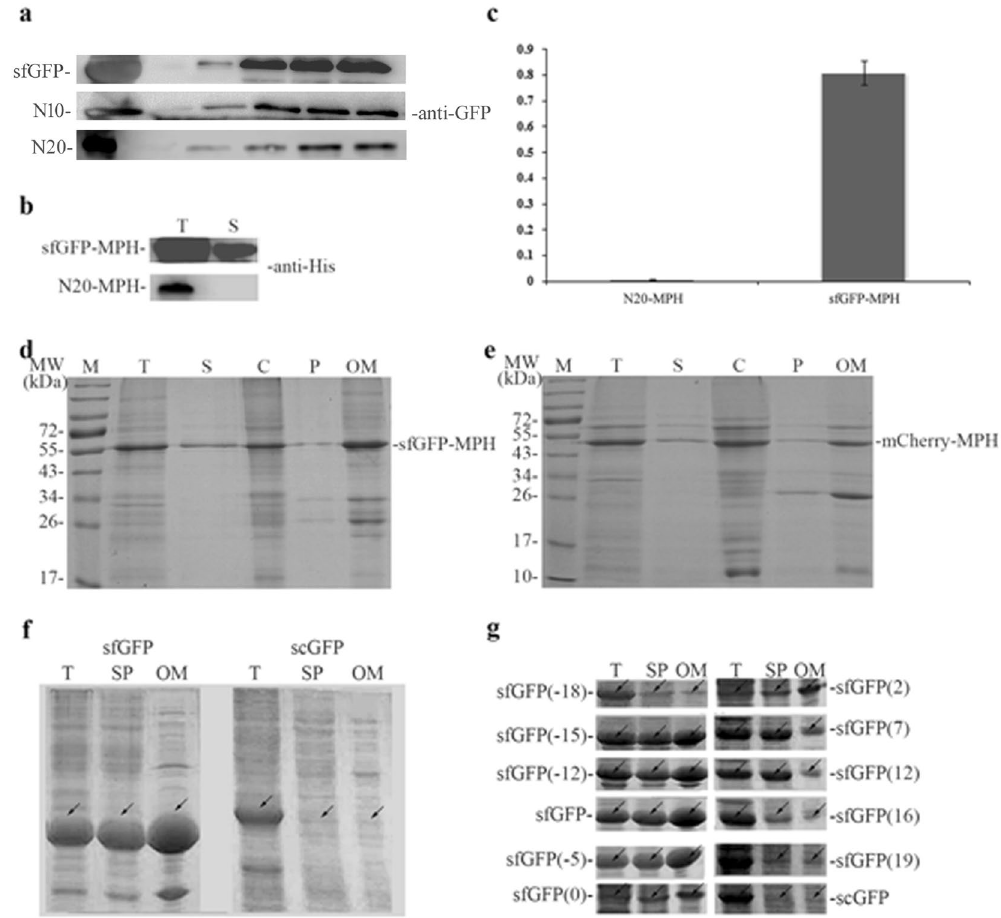
Figure 3. Analysis the auto secetion mechanism of sfGFP in E . coli . ( a ) Western blot annalysis of the extracellular expression of sfGFPs in E . coli ; N10: mutant of sfGFP with deletion of 10 amino acids at its N-terminus; N20: mutant of sfGFP with deletion of 20 amino acids at its N-terminus; anti-GFP: GFP monoclonal antibody; all samples were tested by using GFP monoclonal antibody; ( b ) Western blot annalysis of the extracellualr secretion of sfGFP-MPH and N20-MPH in E . coli ; all samples were tested by using 6 × His mono-antibody; ( c ) Enzyme activity assay of extracellular secretion fusion protein sfGFP-MPH and N20-MPH; N20-MPH: N-terminus 20 amino acids of sfGFP fused to the N-terminal of MPH; sfGFP-MPH: sfGFP fused to the N-terminal of MPH; ( d ) SDS-PAGE annalysis of the sub-fraction of sfGFP-MPH in E . coli ; ( e ) SDS-PAGE annalysis of the sub-fraction of mCherry-MPH in E . coli ; ( f ) SDS-PAGE annalysis of the expression of sfGFP and scGFP in E . coli ; ( g ) SDS-PAGE annalysis of the expression of sfGFP and its mutants in E . coli ; sfGFP( − 18) ~ scGFP: sfGFP mutants containing net charges; T: total cell protein; SP: soluable protein of the target peotein; S: supernatant of culture media; S1~S5: supernatant of culture medium after expression process and stayed at room temperature for 0~4 days; C: cytoplasmic protein; P: periplasmic protein; OM: outer membrane